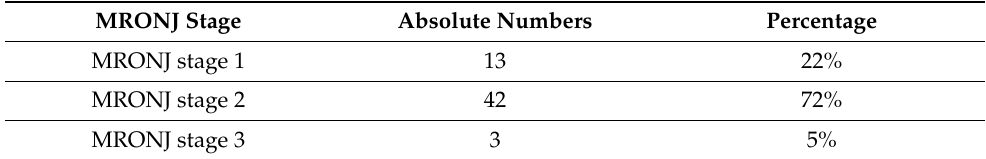
Table 3. MRONJ stages in absolute numbers and percent.